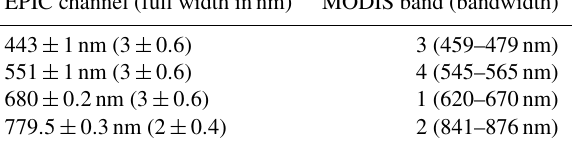
Table 1. EPIC-MODIS channel correspondence. (For simplicity, for the rest of the paper we will call the EPIC NIR channel 780nm.)